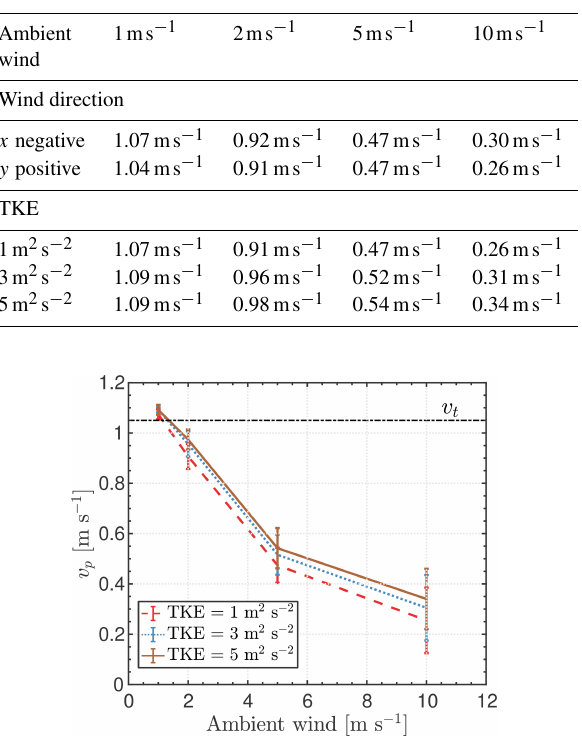
Figure 14. Mean fall speed of particles v p as a function of ambi- ent wind speed. Error bars represent the standard deviation of all the particles at each ambient wind speed. x negative and y posi- tive represent the wind pointing towards − x and + y directions (see Fig. 11d), respectively. Terminal fall speed v t is included for com- parison, and the initial TKE is 1m 2 s − 2 . Data are sampled at the center of the aperture.